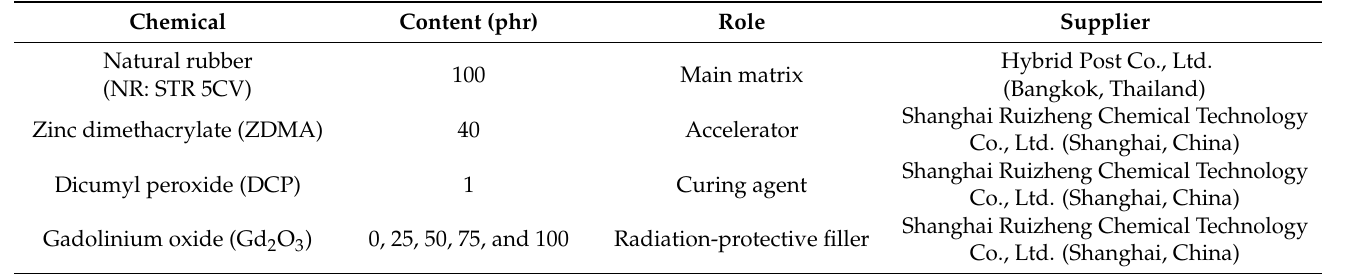
Table 1. Material formulations of Gd 2 O 3 /NR composites and their chemical names, contents, roles, and suppliers.